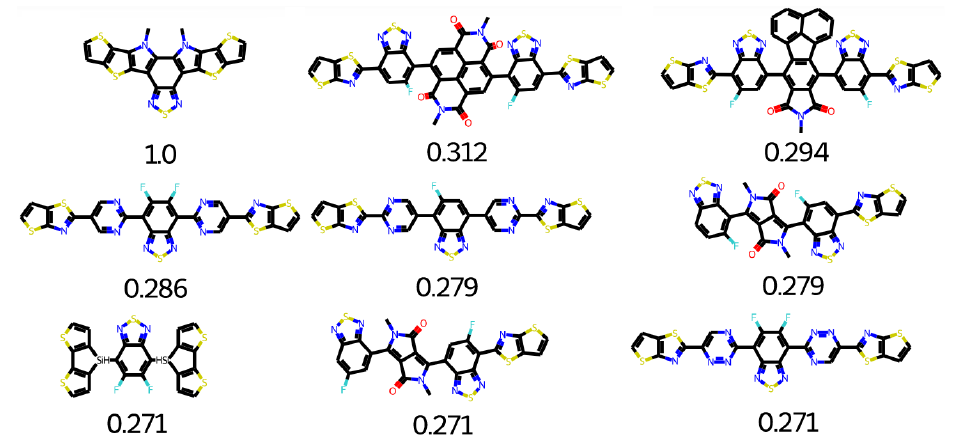
Figure 20. Top search hit for Y5 middle.